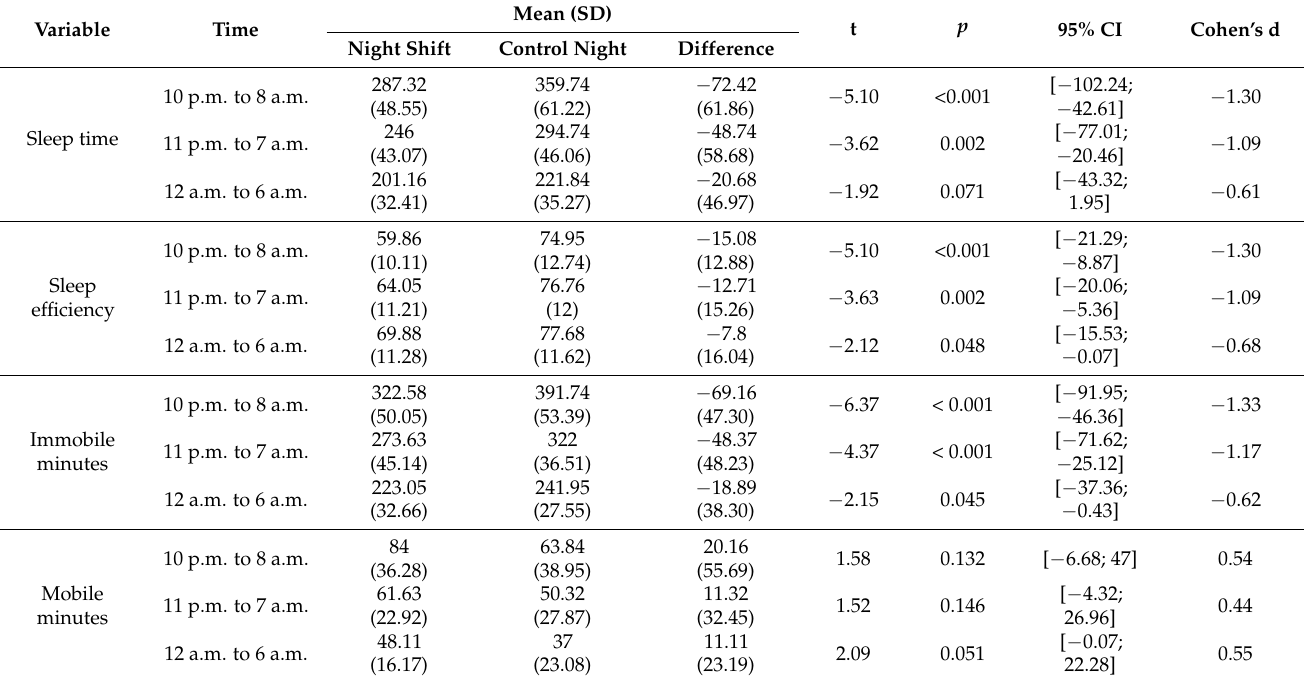
Table 3. Comparison of sleep time, sleep efficiency, and mobile/immobile minutes between the control night and the night shift. CI, confidence interval; SD, standard